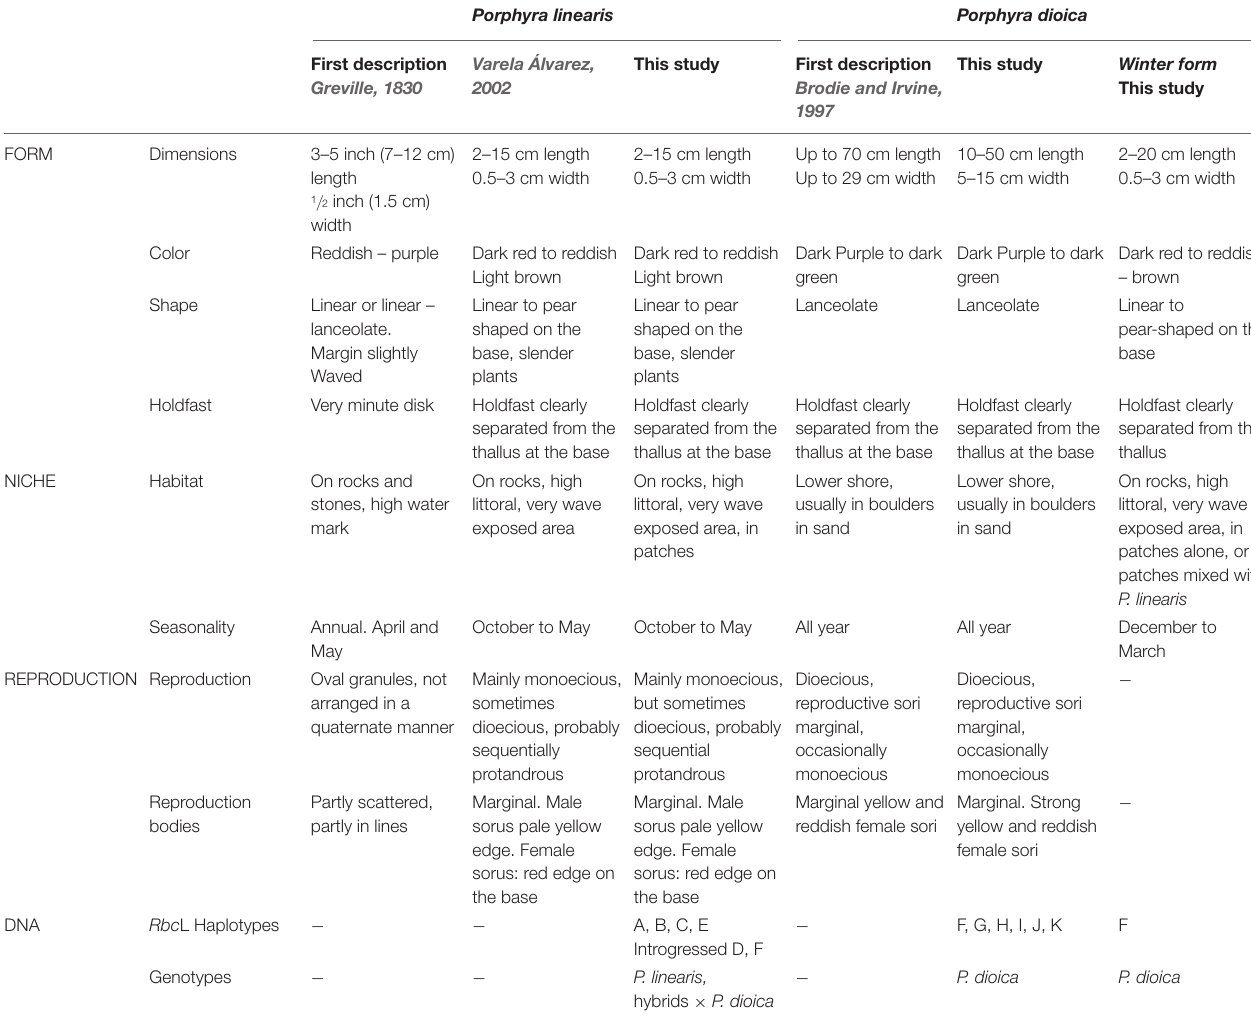
TABLE 2 | Morphological, ecological, reproductive and genetic characters of the species used in this